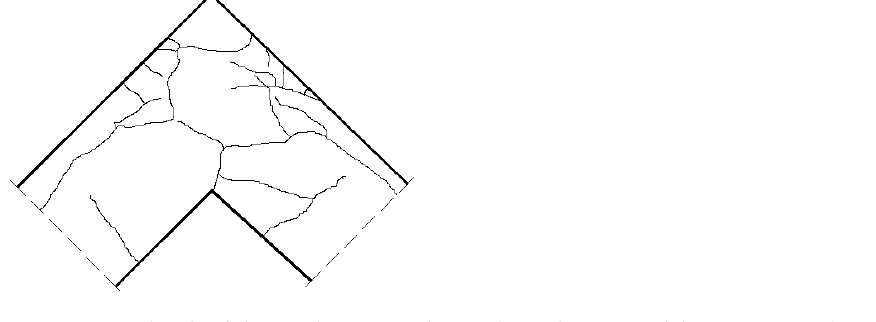
Figure 35. A sketch of the crack pattern obtained in Johansson’s laboratory tests (reprinted with permission from Johansson [13], Copyright 2000, M. Johansson).